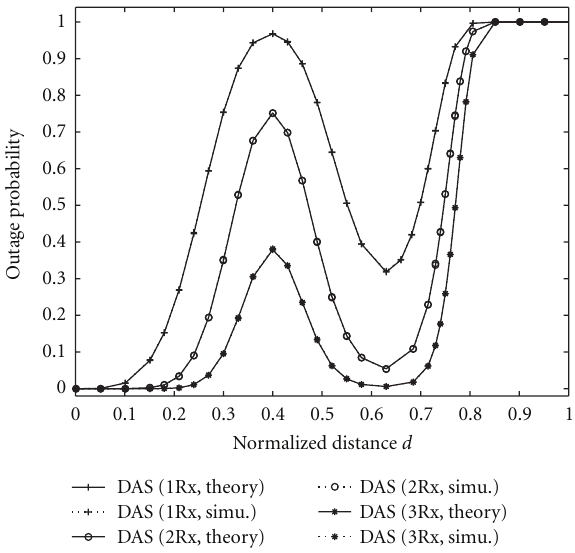
Figure 3: Outage probability versus the normalized distance from the home BS.